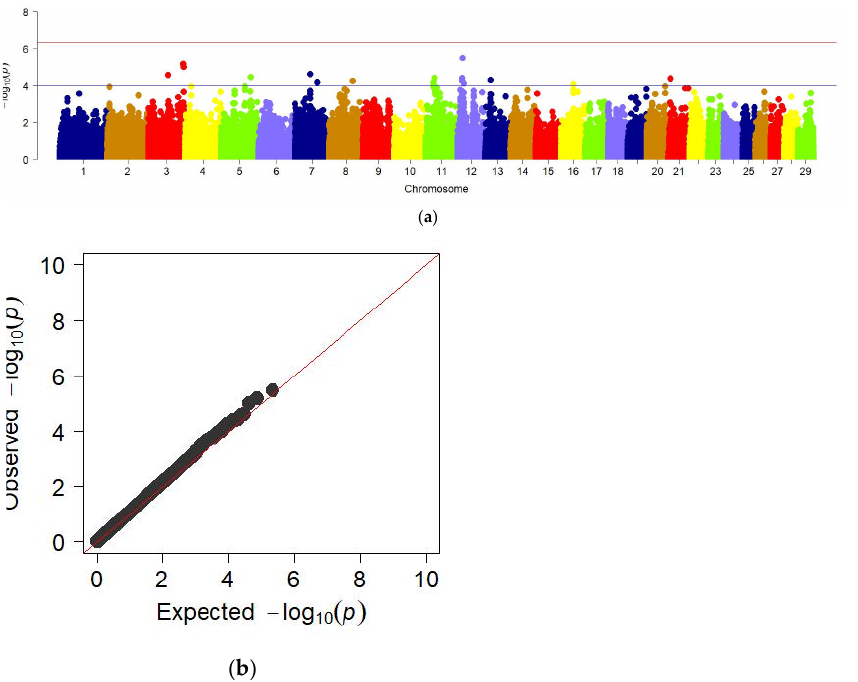
Figure 5. ( a ) Manhattan plots of WGS for chest width with significance thresholds indicated at − log10 p > 4.5 × 10 − 7 ; Panel ( a ) shows the chromosome regions associated with chest width, using ~150,000 imputed sequence SNPs. ( b ) The quantile-quantile (QQ) plots for the studied quality trait. Panels ( b ) have shown the QQ plots for the chest width trait.